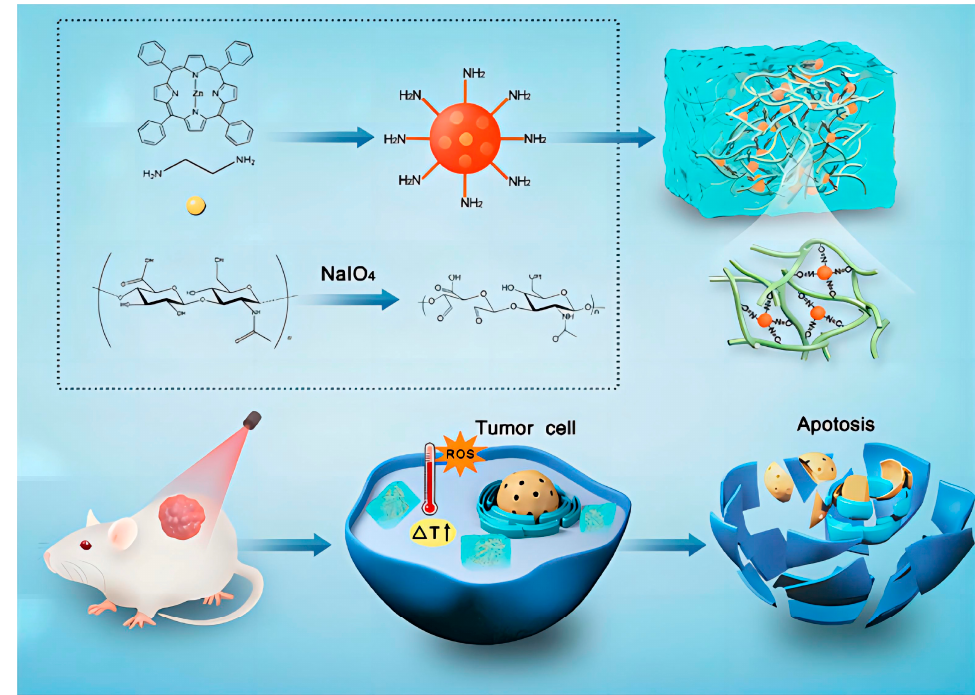
Figure 5. Schematic Diagram of the Synthesis Process of CD@Hydrogel and Its Application in Can- cer Treatment [40]. Copyright 2022, American Chemical Society. Treatment [40]. Copyright 2022, American Chemical